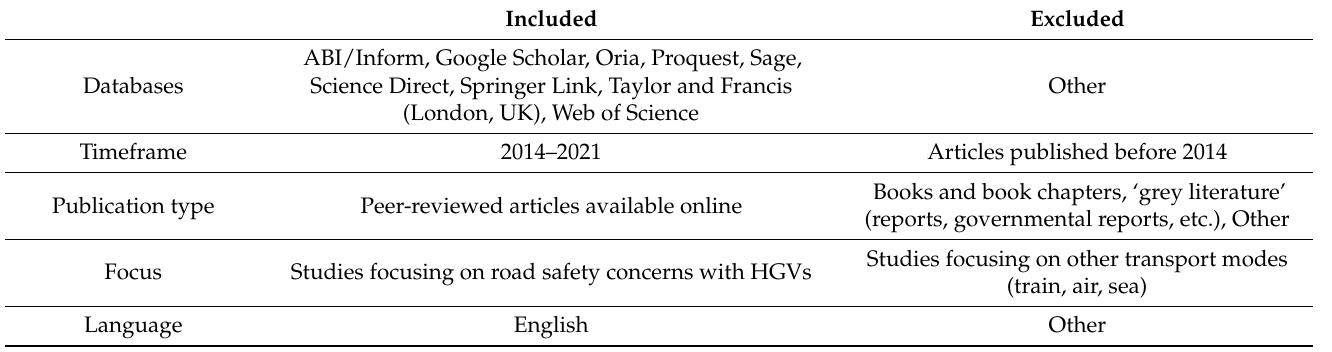
Table 1. Inclusion and exclusion